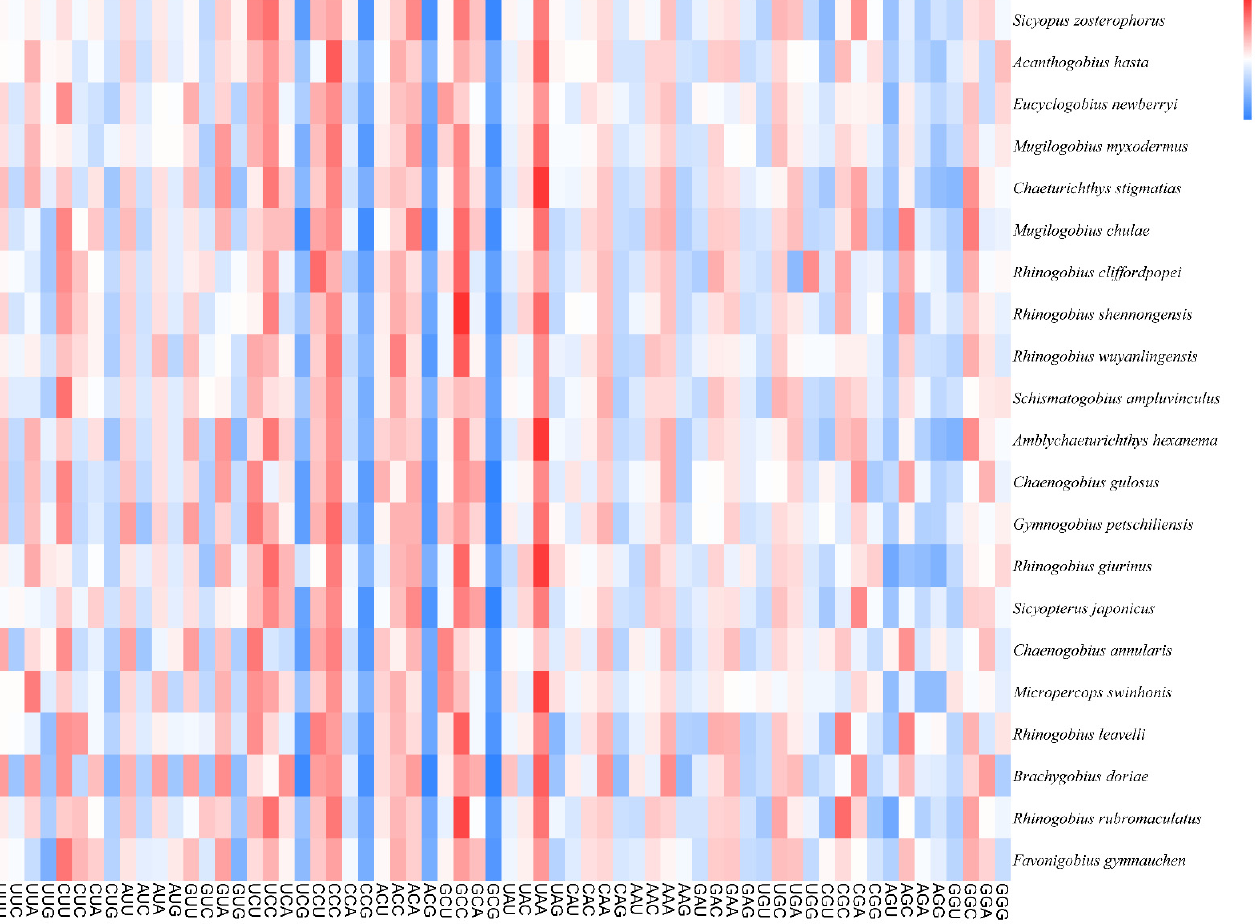
Figure 3. Heatmap based on codon usage of the 21 species evaluated in this study.